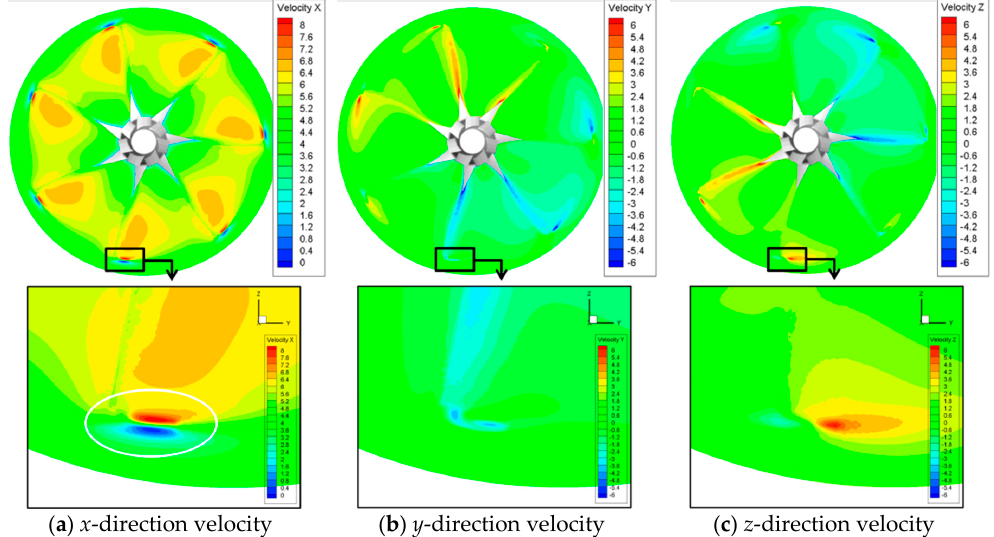
Figure 14. Reynolds-averaged Navier–Stokes (RANS) simulation results on Model-A: ( a ) x -dir. velocity; ( b ) y -dir. velocity; ( c ) z -dir. velocity.